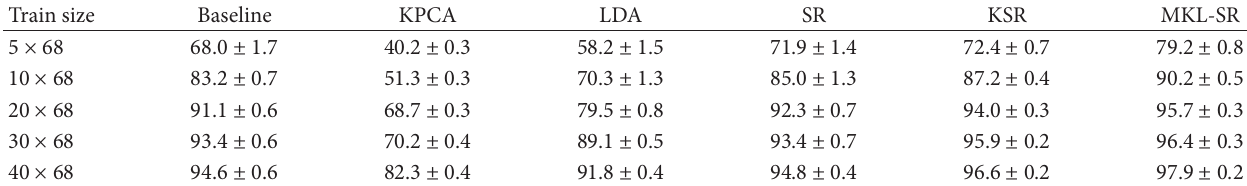
Table 3: Recognition accuracy rates on PIE (mean ±